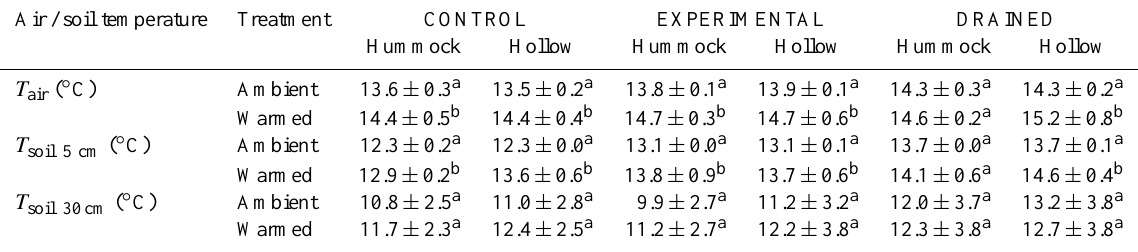
Table 1. Mean seasonal air temperatures ( T air ) , soil temperatures at 5cm depth ( T soil 5cm ) and soil temperatures at 30cm depth ( T soil 30cm ) at all the sites, measured during growing seasons (May to October) of 2011–2013 ∗